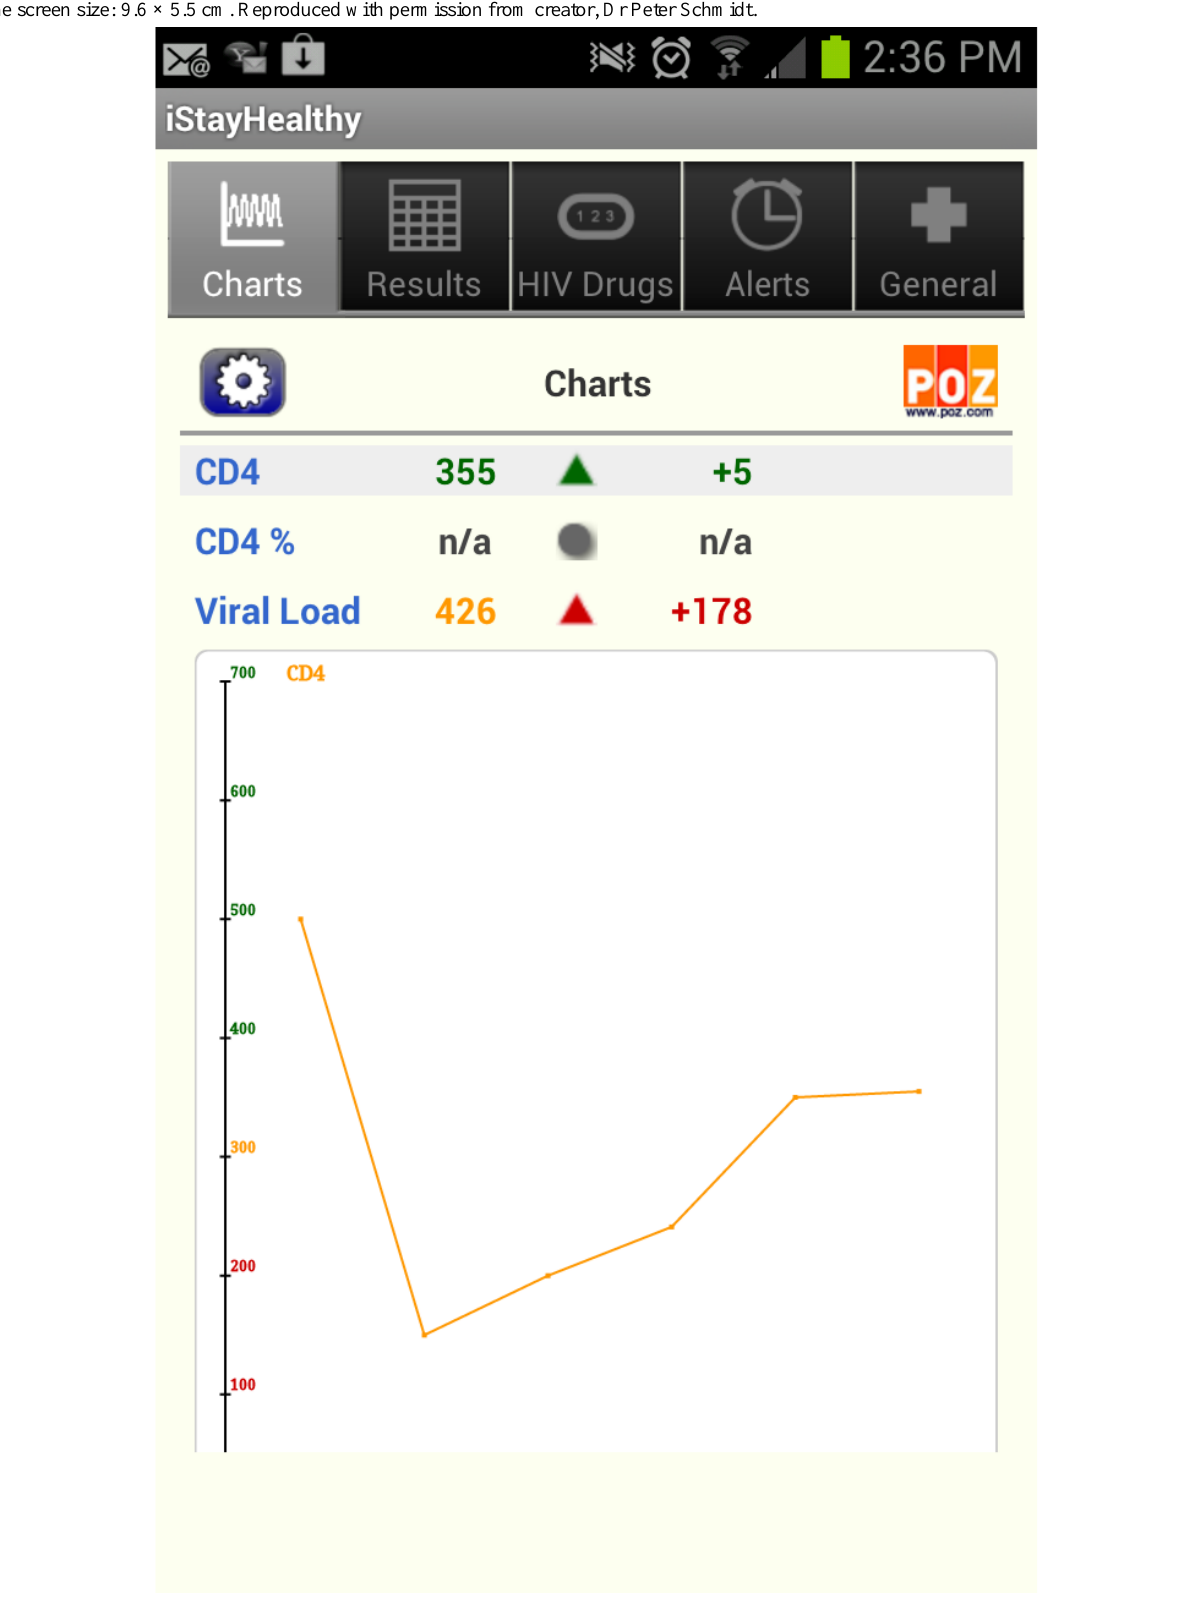
Figure 2. Screenshot of the iStayHealthy app’s user-generated CD4 cell count tracking. Android version shown on Samsung Galaxy S IV. Actual phone screen size: 9.6 × 5.5 cm. Reproduced with permission from creator, Dr Peter